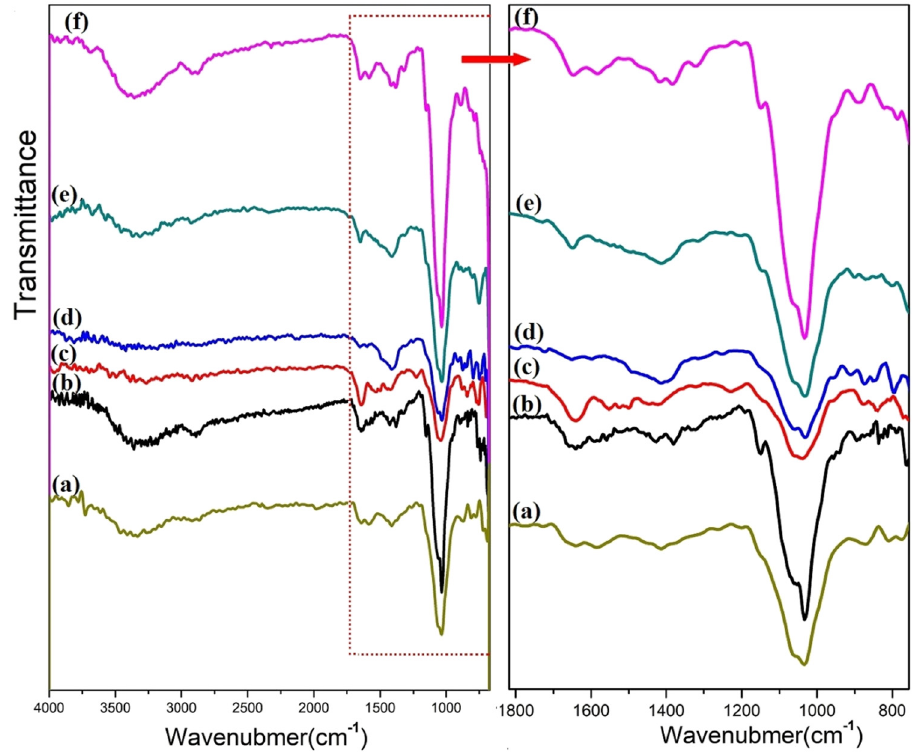
Figure 1: FT - IR spectra of the composite membranes: ( a ) CS/n - HA ( 6:2 ) , ( b ) SF/CS/n - HA ( 1:6:2 ) , ( c ) SF/CS/n - HA ( 2:6:2 ) , ( d ) SF/CS/n - HA ( 6:6:2 ) , ( e ) un - degummed SF/CS/n - HA ( 1:6:2 ) , and ( f ) dissolved SF/CS/n - HA ( 1:6:2 )